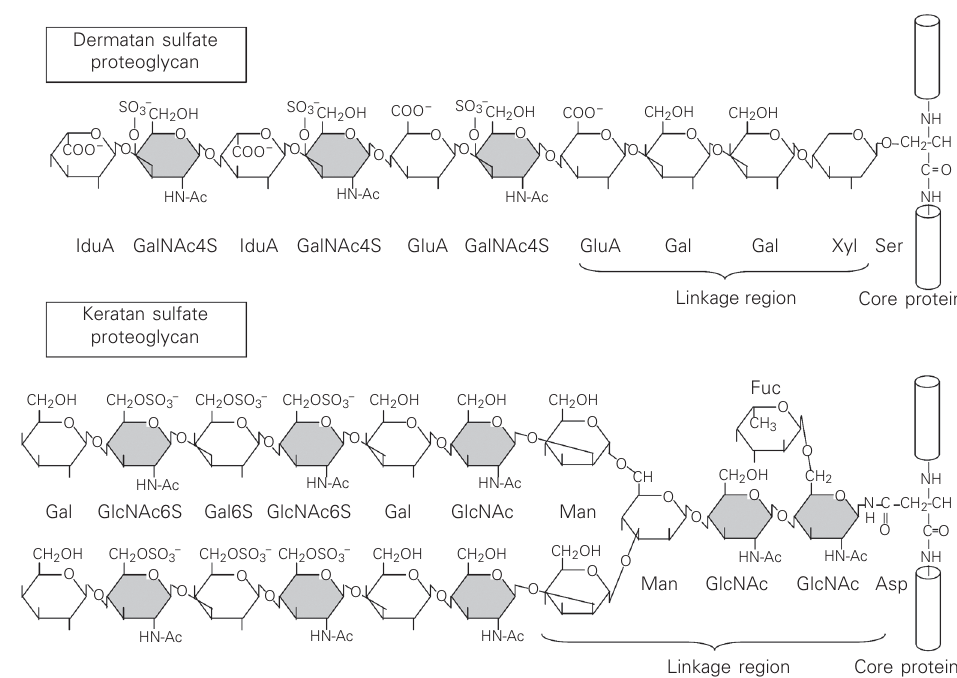
Figure 4. Structure of corneal matrix glycosaminoglycans showing the polysaccharide-pro- tein linkage region and the main disaccharide units. Gal, galac- tose; Fuc, fucose; Man, man- nose; Xyl, xylose; GluA, ß-D-glu- curonic acid; IduA, α -L-iduronic acid; GalNAc, N -acetylgalactos- amine; GalNAc4S, N -acetylgalac- tosamine 4-sulfate; GlcNAc, N - acetylglucosamine; GlcNAc6S, N -acetylglucosamine 6-sulfate; Asp, asparagine; Ser,